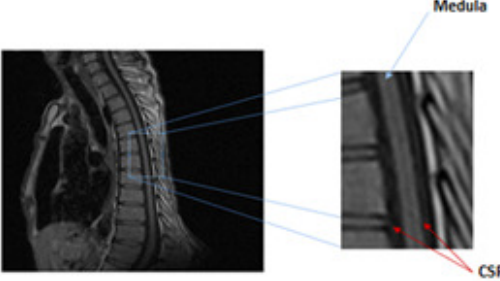
Figure 2. Region of the CSF in MRI type T1. Source: